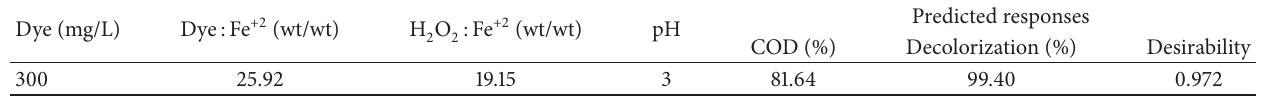
Table 5: Optimized operating parameters.